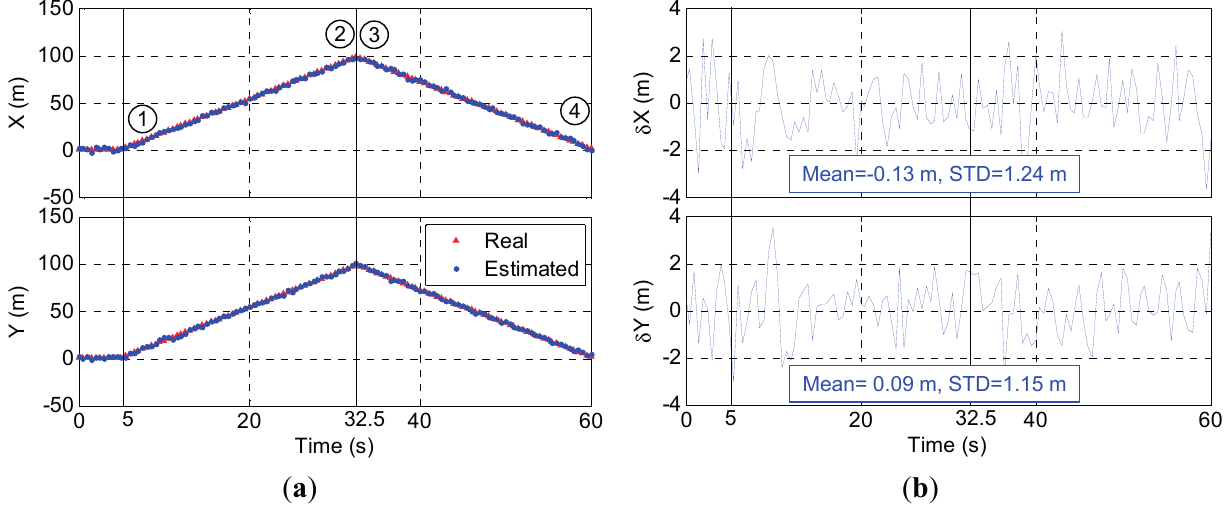
Figure 11. Dynamic simulation results: ( a ) positioning results and ( b ) positioning error.